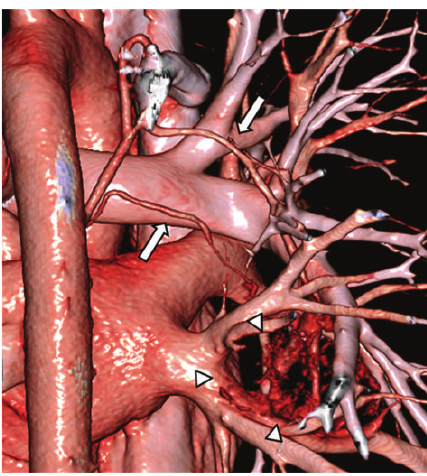
Figure 3: 3D-CT angiography demonstrated the enlarged feeding vessels at the surface of the mass (arrowheads) originating from 2 bronchial arteries (arrows).